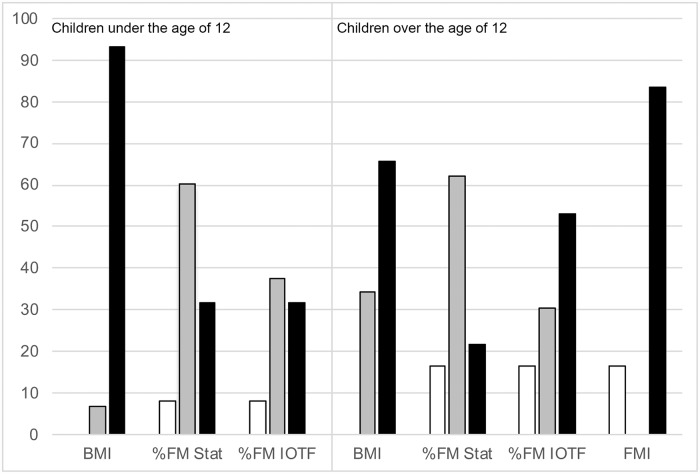
Nutritional classification based on the Z-BMI, the Z-% fat mass and the fat mass index in stratified sample (children under the age of 12 and children over the age of 12).The bars represent percentage of children. Black bars: obesity; grey bars: overweight or overfat; white bars: normal fat or non-obesity. BMI: body mass index; FM: fat mass; Stat.: cut-offs according to the statistical criteria; IOTF: cut-offs according to the IOTF criteria; FMI: fat mass index.